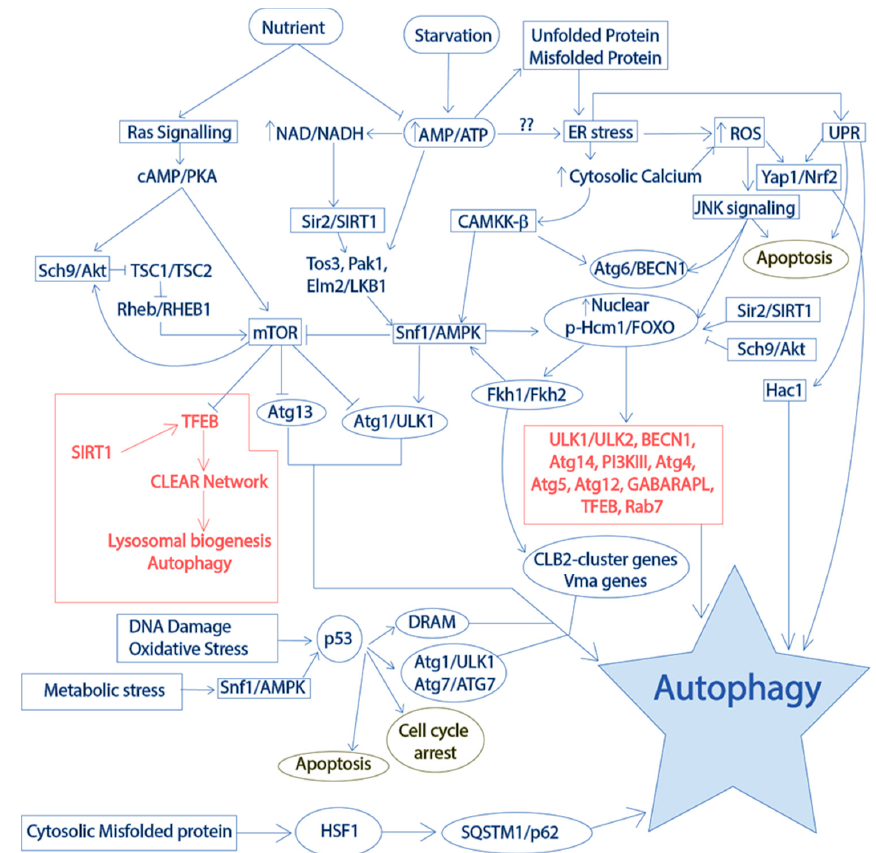
eukaryotic cell. In normal conditions, protein folding in the cytoplasm is carried out with the help of chaperones, especially heat shock proteins (HSPs) of the HSP70 family [29]. Any aberrations in protein folding will trigger a heat shock response through activation of heat shock factor 1 (HSF1), which enhances expression of chaperones for repairing the folding and promotes activation of autophagy for clearance of the unfolded or misfolded proteins [278].